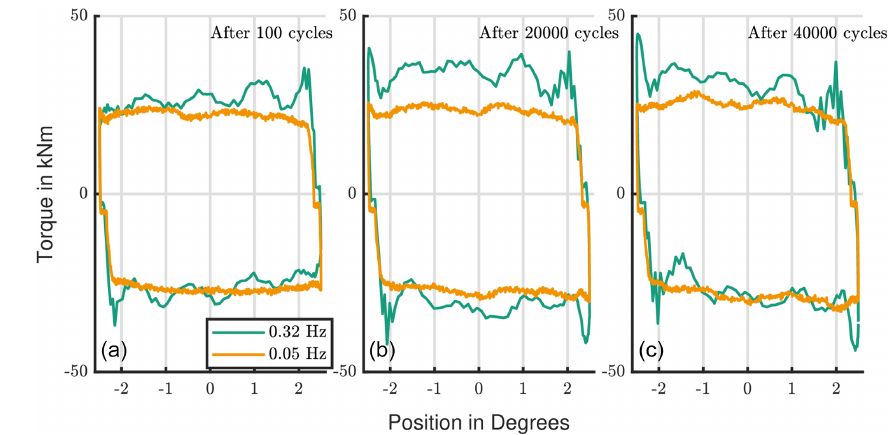
Figure 9. Torque development with increasing number of cycles: comparison of oscillation frequencies of 0.32 and